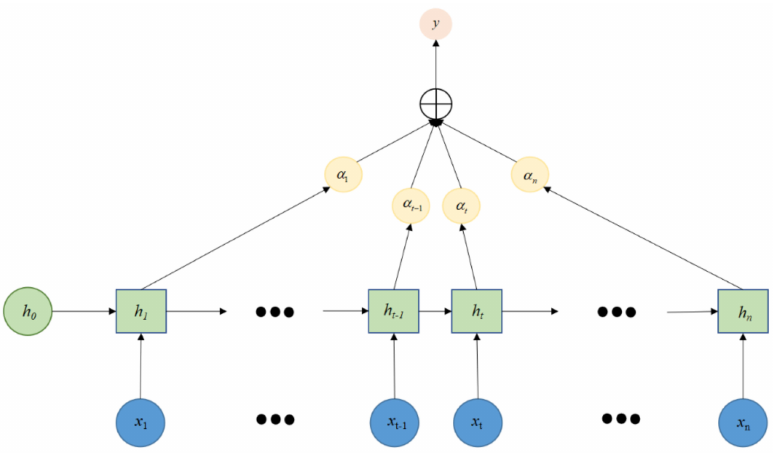
Figure 5. Attention mechanism